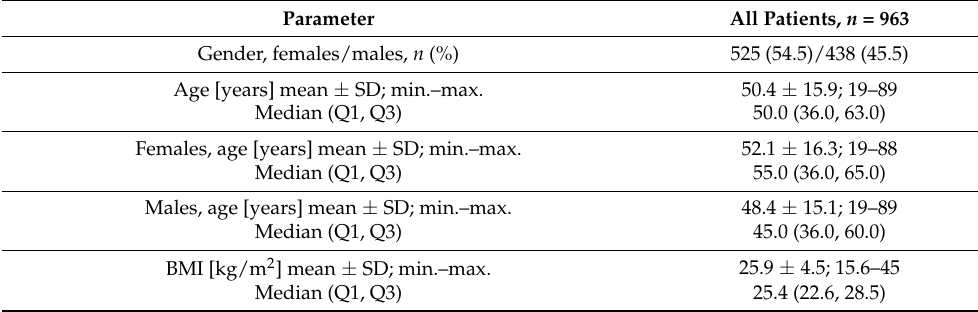
Table 1. Baseline Characteristics of HCV-Infected Patients Treated with IFN-Free